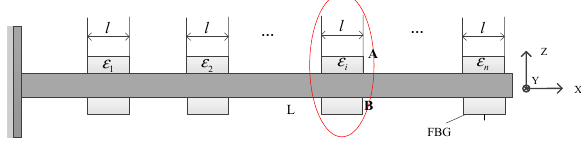
Figure 3. Schematic diagram of the deformation of FBG sensor.